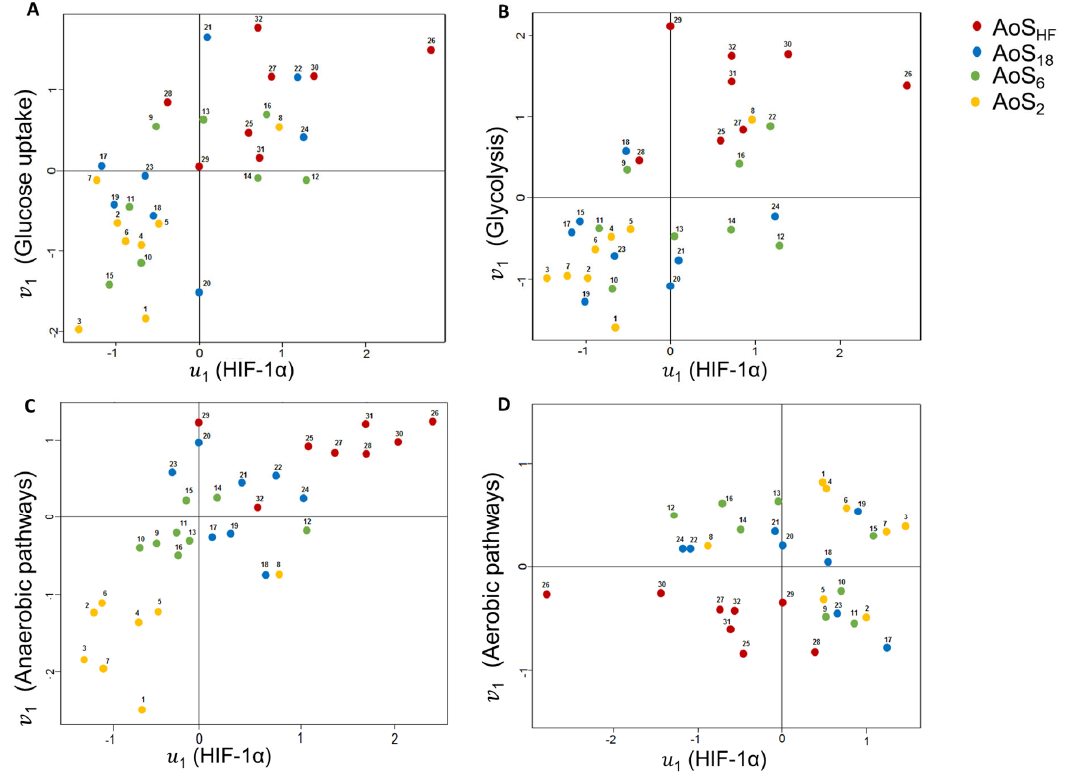
Figure 10. Scatter plot of canonical variables in aortic stenosis groups. AoS: supravalvar aortic stenosis; HF: heart failure; • AoS 2 , 2 weeks; • AoS 6 , 6 weeks; • AoS 18 , 18 weeks; • AoS HF , HF; HIF-1 α : factor inducible hypoxia. ( A ) Insulin signaling and glucose transporters 1 and 4 (total and phosphorylated insulin receptor, total and phosphorylated protein kinase B, phosphoinositide 3-kinase and glucose transporter 1 and 4 expression); p < 0.027. ( B ) Glycolysis (hexokinase activity, hexokinase II, phosphofruct kinase 2 and pyruvate kinase expression); p < 0.018. ( C ) Anaerobic pathways (lactate dehydrogenase expression and activity); p < 0.024. ( D ) Aerobic pathways (pyruvate dehydrogenase expression and citrate synthase activity); p < 0.957. Canonical correlations: insulin signaling and glucose transporters 1 and 4, 0.671; glycolysis, 0.625; anaerobic pathways, 0.675; aerobic pathways, 0.054. u 1 = 1.00 (HIF-1 α ). Insulin signaling and glucose transporters 1 and 4: A ν 1 = 0.40 pIR + 0.23 total IR + 0.56 pAKT − 0.01 total AKT + 0.54 PI3K + 0.74 GLUT1 + 0.26 GLUT4. Glycolysis: A ν 1 = 0.32 HKII + 0.66 HK + 0.81 PFK2 + 0.28 PK. Anaerobic pathways: A ν 1 = 0.45 LDH − 0.99 LDH activity. Aerobic pathways: A ν 1 = 0.789 PDH + 0.723